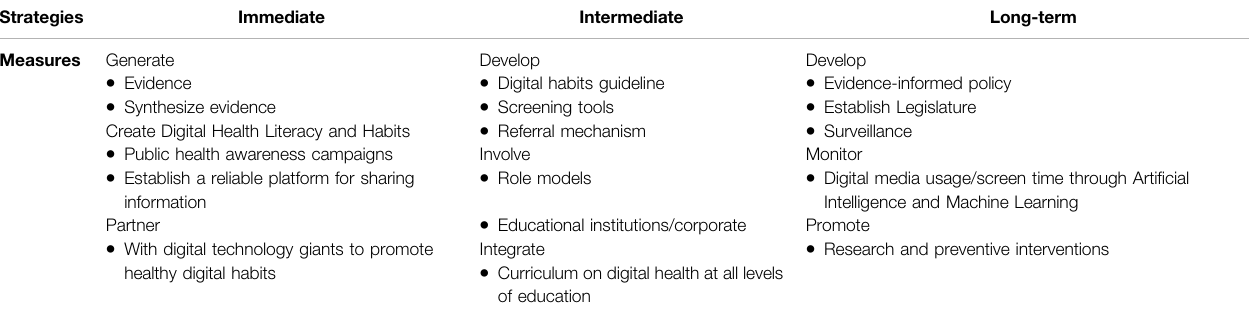
TABLE 3 | A three-pronged approach to promote social connectedness through healthy digital habits.